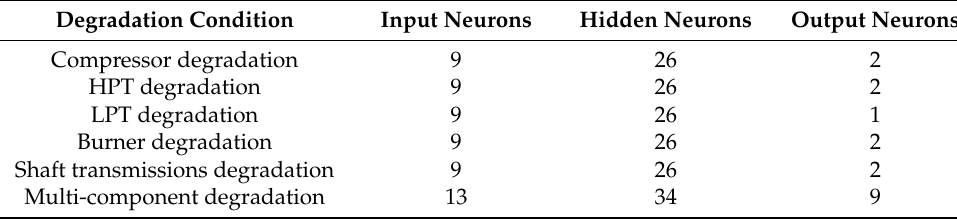
Table 6. Characteristics of neural networks with reduced